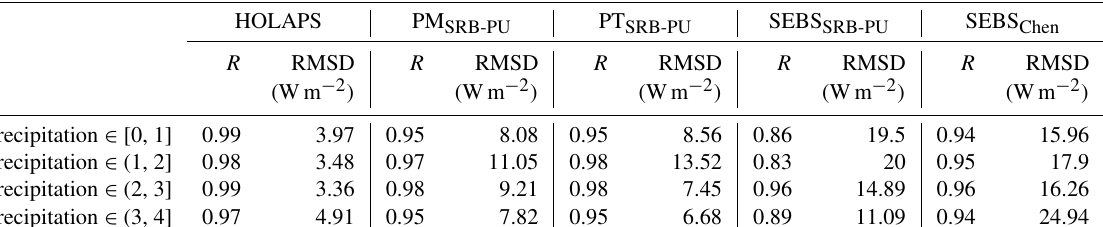
Table 5. Statistics of the LE comparisons between the LandFlux-EVAL benchmark product and other products over different precipitation thresholds.